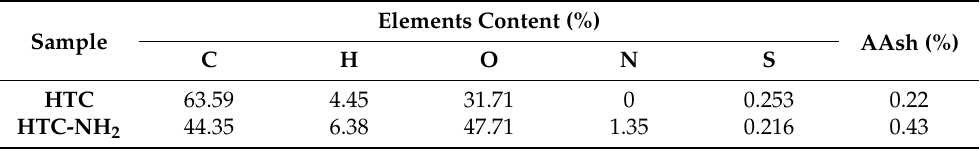
Table 1. Elements contents of hemicelluloses hydrothermally treated with citric acid (HTC) and HTC-NH 2 by elemental analysis.